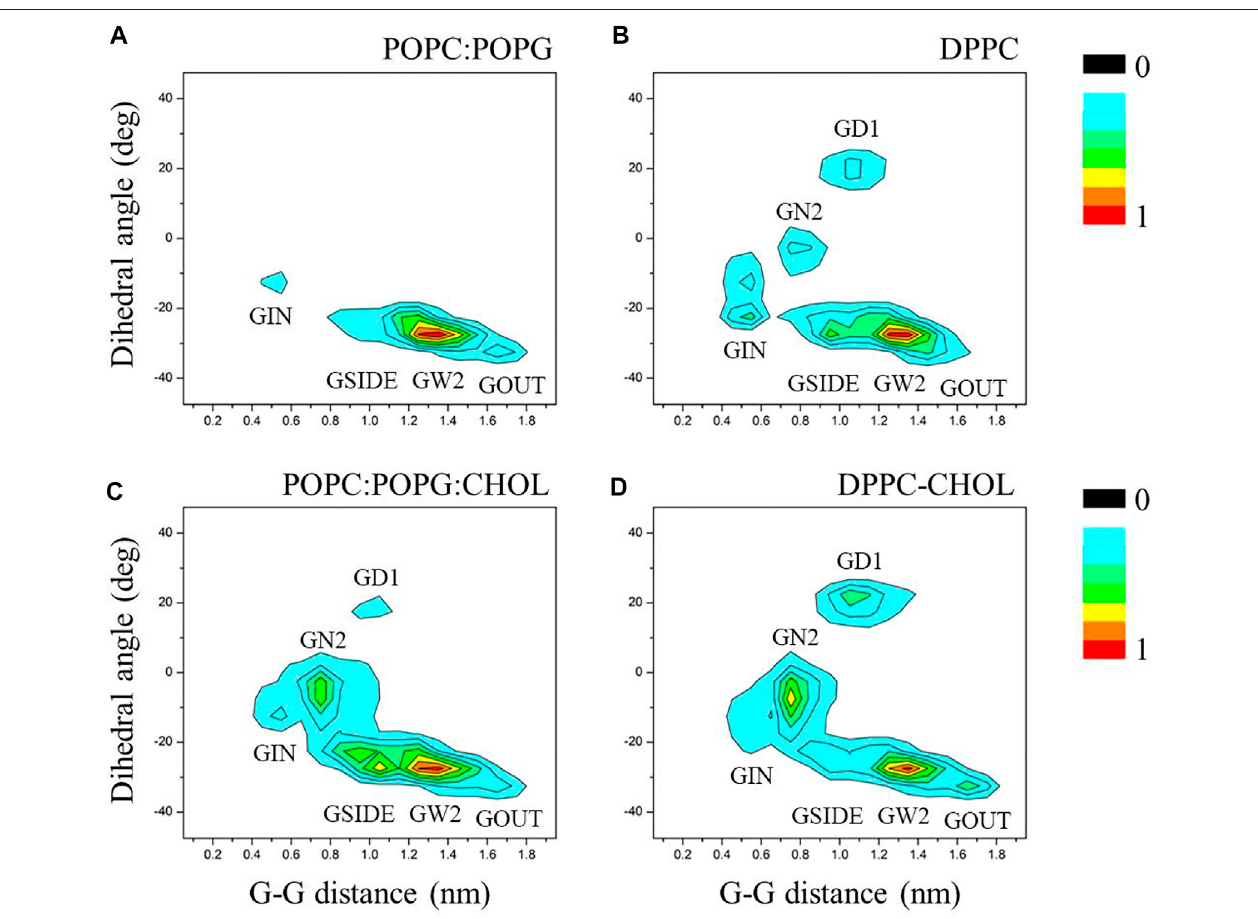
FIGURE6| ThedistributionsforC99homodimerwereprojectedontothe orderparameters of Ω andG − G,usingthedatacollectedafterC99forms adimer. (A) In POPC:POPG bilayer without cholesterol. (B) In DPPC bilayer without cholesterol. (C) In POPC:POPG bilayer with 20% cholesterol. (D) In DPPC bilayer with 20%